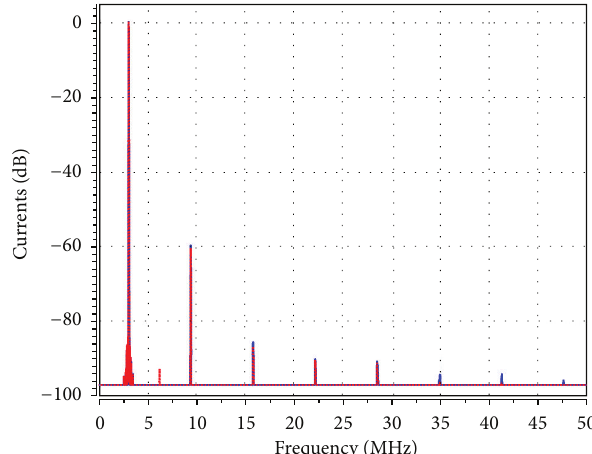
Figure 13: Phase error as a function of oscillation frequency (blue: phase error versus 𝑉 𝑜1 and 𝑉 𝑜2 and red: phase error versus 𝐼 𝑜1 and 𝐼 𝑜2